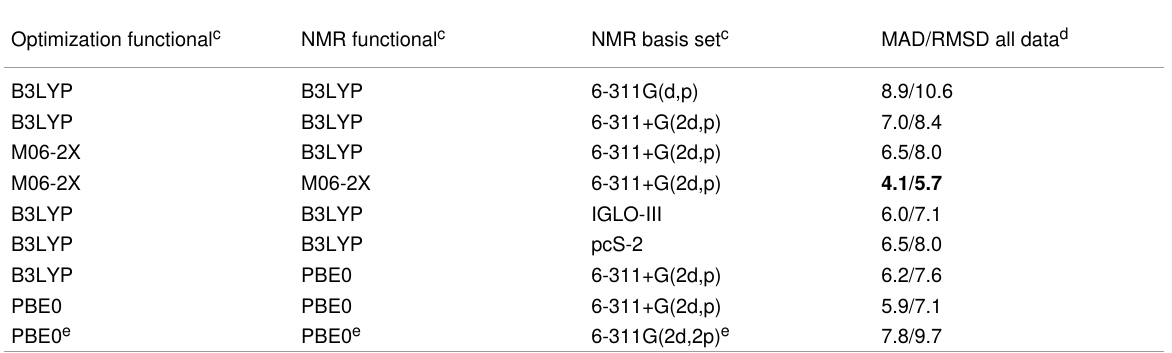
Optimization functional